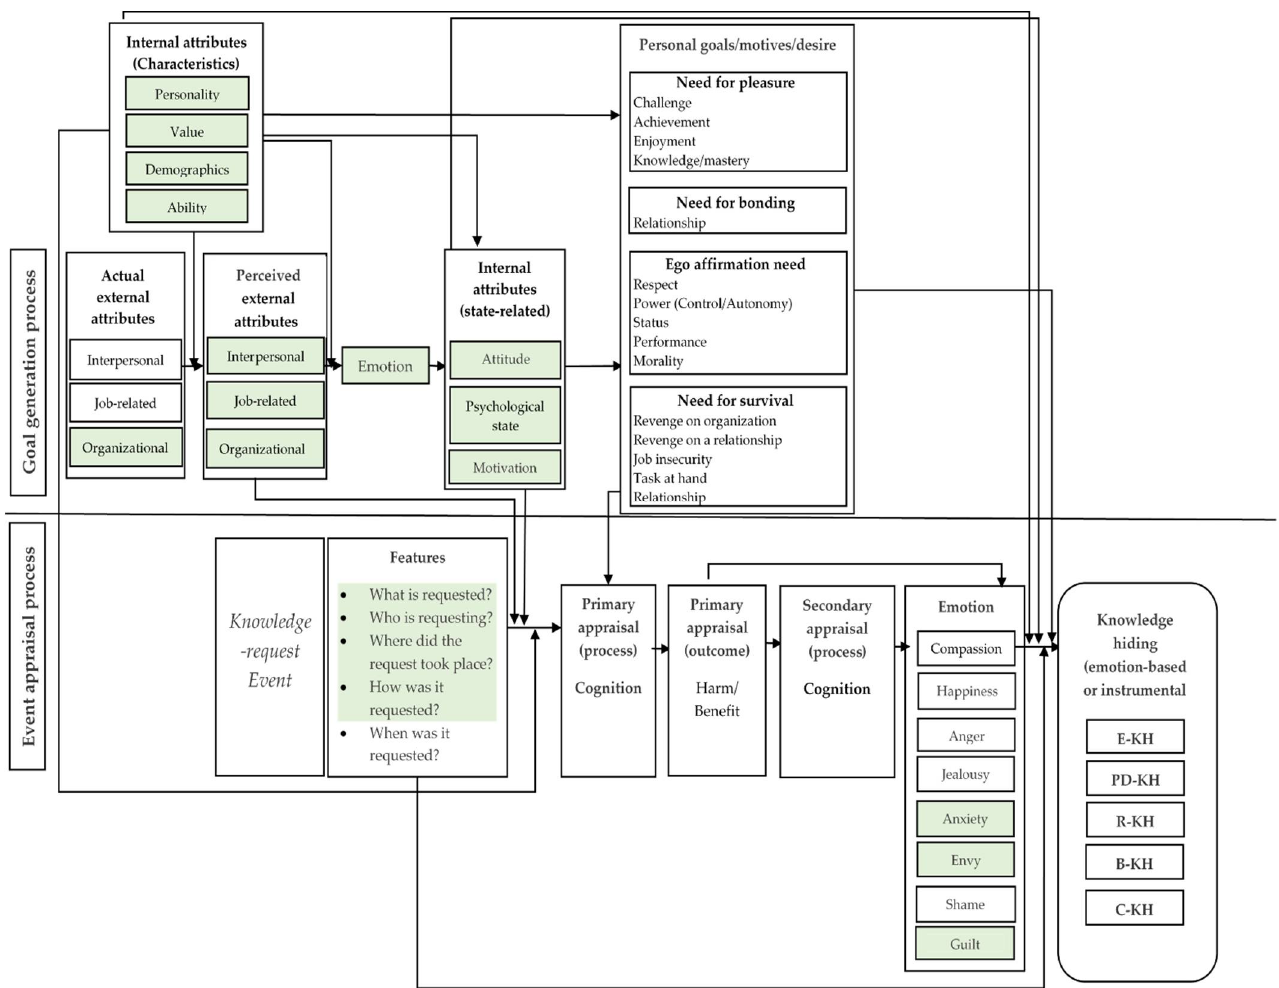
Figure 3. The CMR theory-based framework explains the psychological process behind KH. Notes: The colored boxes are the categories that have been analyzed in the previous studies. E-KH: evasive knowledge hiding, PD-KH: playing dumb knowledge hiding, R-KH: rationalized knowledge hiding, B-KH: bullying knowledge hiding, C-KH: counter questioning knowledge hiding.